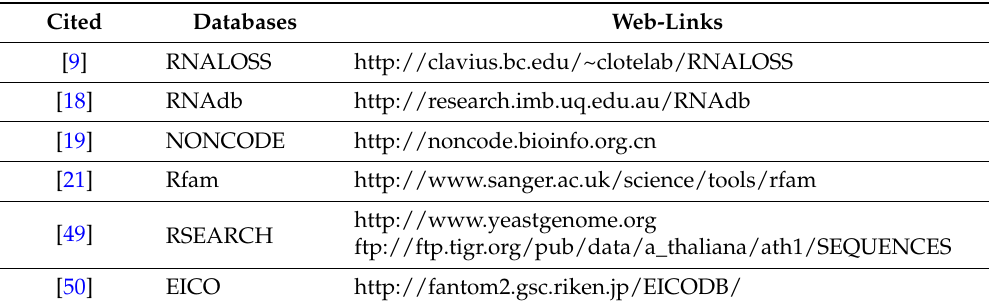
Table 3. State-of-the-art CI online databases for the development of CI